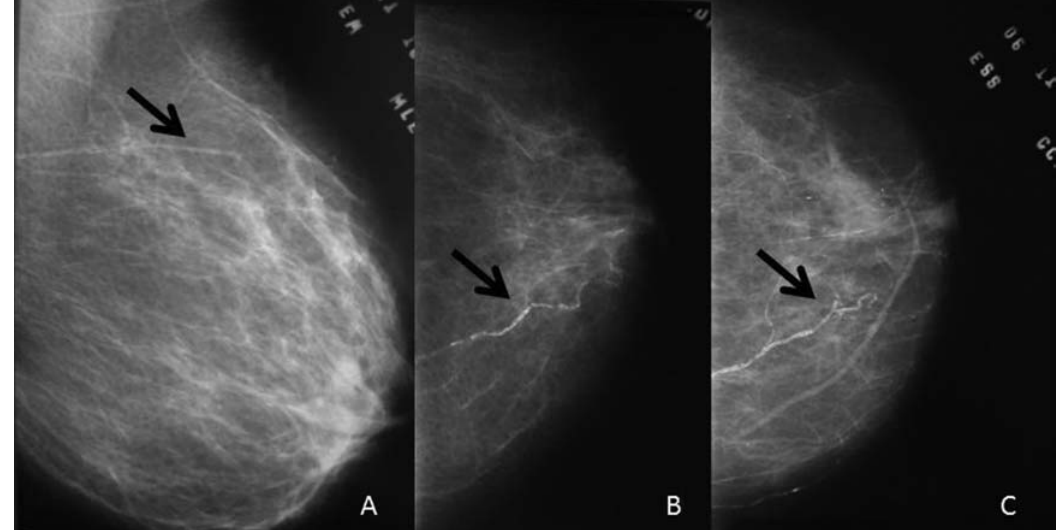
Figure 1 - Classification of the intensity of vascular calcifications: a) slight: Arteries with few calcifications at large distances from each other (more than 10 mm); b) moderate: Arteries clearly outlined by calcifications over a considerable proportion of their course; c) severe: Arteries extensively affected, seen as almost continuous columns of calcification with at least two branches also visible